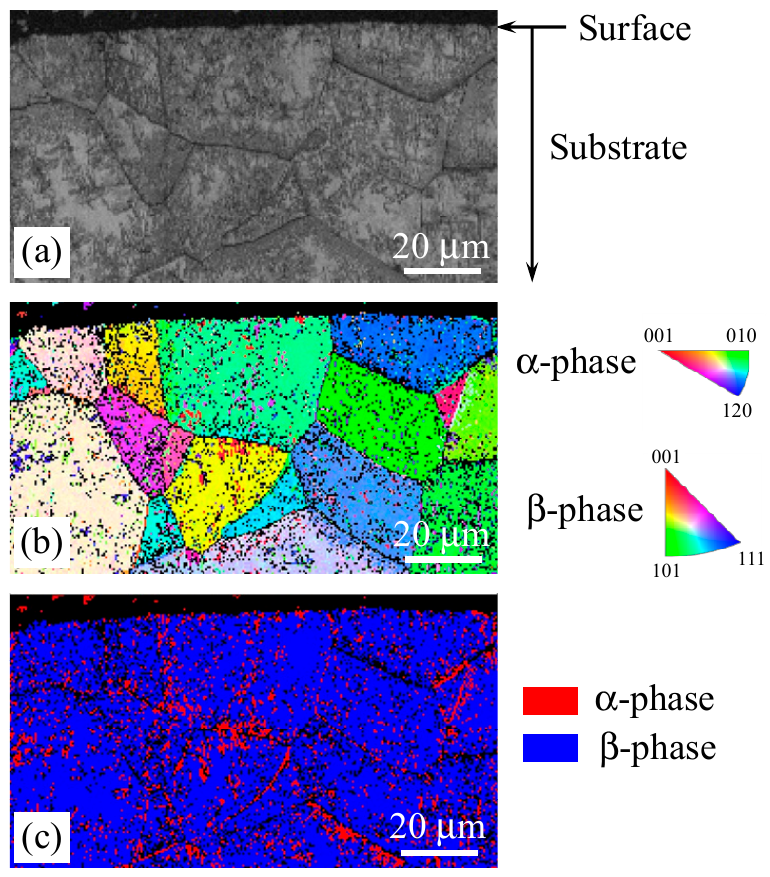
Figure 6. EBSD analysis for cross section of FPP-treated specimen: ( a ) image quality (IQ) map; ( b ) IPF map; ( c ) phase map.